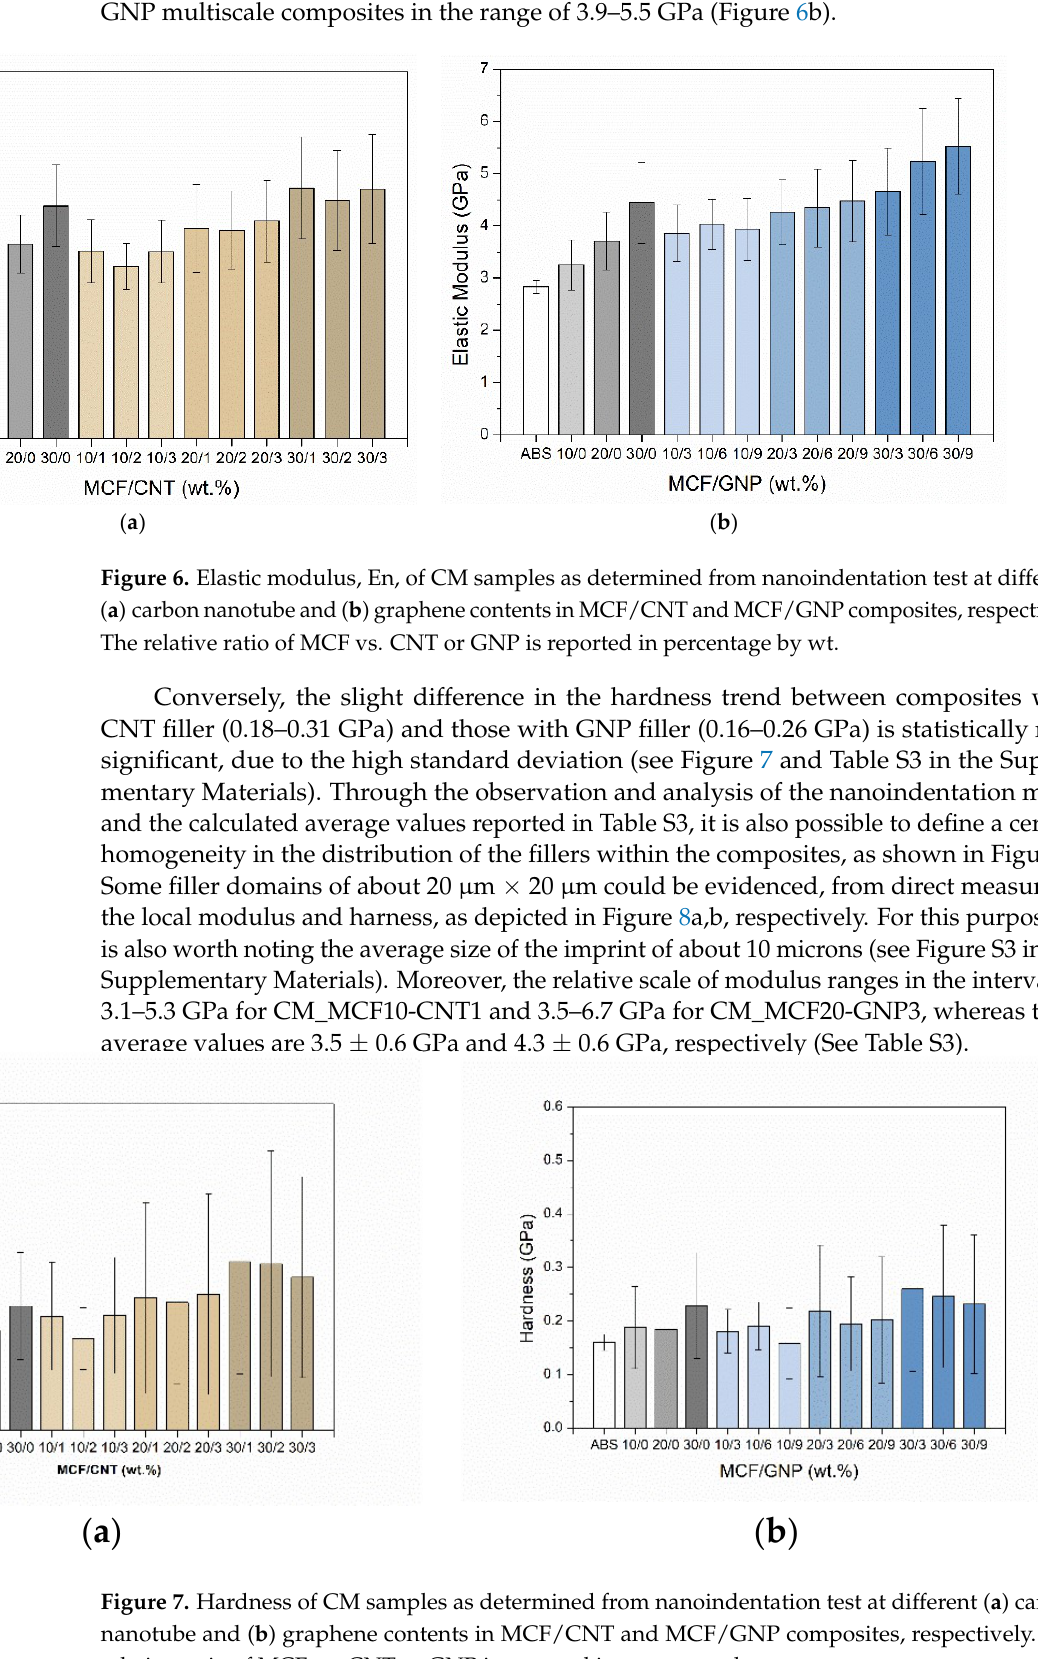
Figure 8. Example of the map of elastic modulus, En ( a , c ), and hardness, H ( b , d ), of samples CM_MCF10-CNT1 ( a , b ) and CM_MCF20-GNP3 ( c , d ).